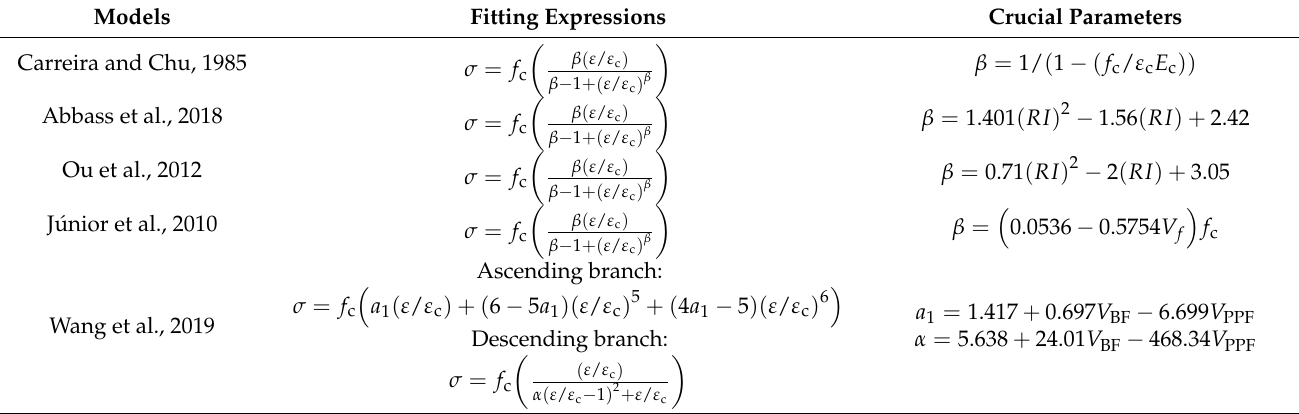
Table 8. Existing stress–strain models for concrete in compression. Fitting Expressions Crucial